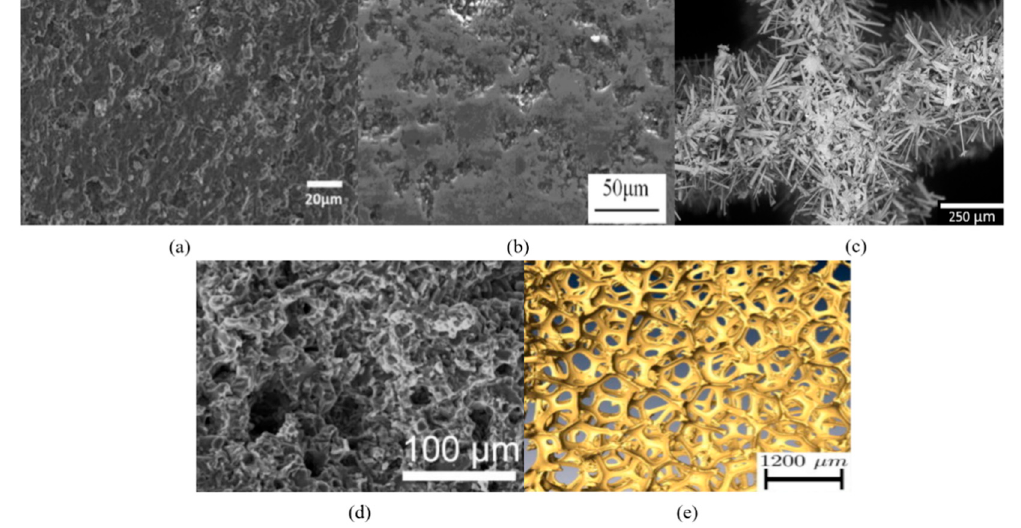
Figure 4. SEM images of the DPF substrate materials: ( a ) cordierite [59]; ( b ) SiC [60]; ( c ) acicular mullite [61]; ( d ) aluminum titanate [62]; and ( e ) alloy foam [63]. Cordierite is the most widely used DPF filter material. Its main advantages are low cost, low coefficient of thermal expansion, high temperature resistance [64], and high me- chanical strength [65]. Cordierite has a low thermal quality and good coating perfor- mance, so its catalyst has a short ignition time [66,67]. The cordierite trap has high conver- sion efficiencies of CO and HC at low temperatures which can reduce the particles gener- ated in the cold start-up stage and the catalyst heating stage. Cordierite also has some disadvantages, such as poor corrosion resistance, higher radial expansion coefficient than axial expansion coefficient, smaller thermal conductivity, and so on. The internal heat can- not be dissipated, and the filter will crack if the thermal conductivity is low. At the same time, the specific heat capacity of cordierite is smaller, so it is necessary to design a larger wall thickness and channel density, which will lead to an increase in exhaust back pres- sure and total heat capacity [68]. Therefore, Ki et al. [69] proposed that the sintering at- mosphere is an important parameter to measure cordierite. In their study, it was found that the sintering atmosphere affected the pore size and distribution of the DPF and greatly affected its filtration efficiency. Compared with cordierite, SiC has better heat resistance, heat conduction, and cor- rosion resistance as well as higher mechanical strength [70]. The thermal conductivity and thermal quality of SiC are very high. During regeneration, it can quickly dissipate the heat generated by PM combustion, reduce the damage to materials, and work in a worse re- generation environment. The main defect of SiC is poor thermal shock resistance, as the filter cracks easily at a high temperature [71]. Therefore, the DPF with SiC as the filter material generally uses ceramic fiber to bond the components into a whole rather than a honeycomb structure. This structure can improve the thermal shock resistance, but also increase the exhaust back pressure. Compared with diesel, SiC-CDPF can help biodiesel reduce power loss [72]. The development of the DPF design includes the optimization of cell shape and cell wall porosity to minimize back pressure on the engine, extend filter service intervals, and promote catalyst coating. Zhang et al. [73] analyzed the structure and operation factors of DPFs by using the orthogonal experimental method. It was concluded that wall thickness and porosity are the two most important factors affecting plugging, which puts forward a scientific basis for improving the DPF structure. Figure 5 shows the loading structure of most DPF experiments.